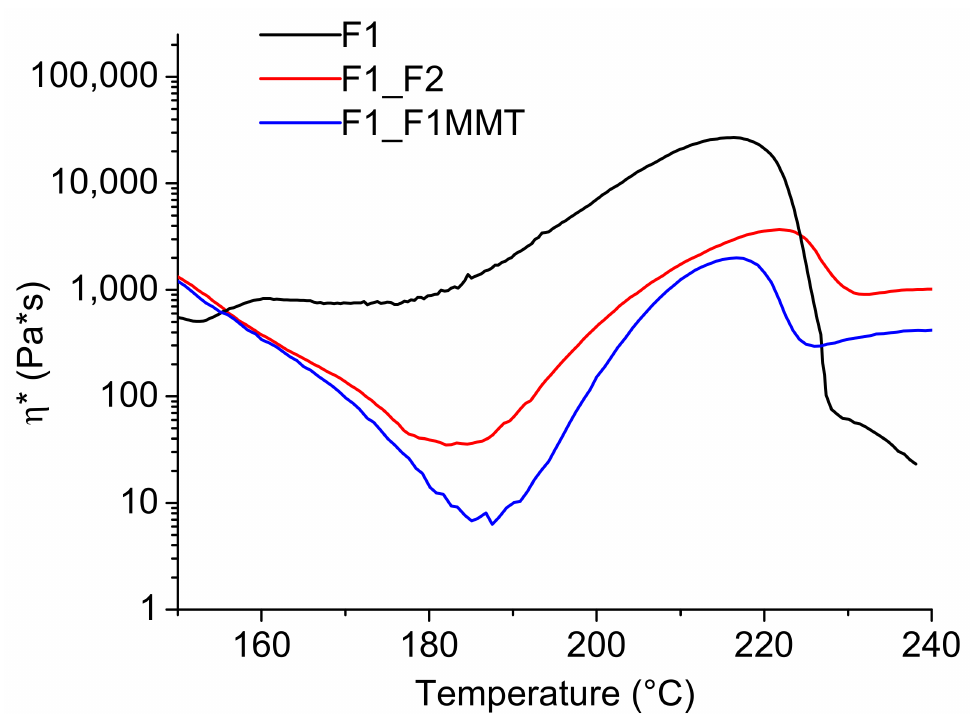
Figure 4. Dynamic temperature ramp tests on cyclic butylene-terephthalate (CBT)